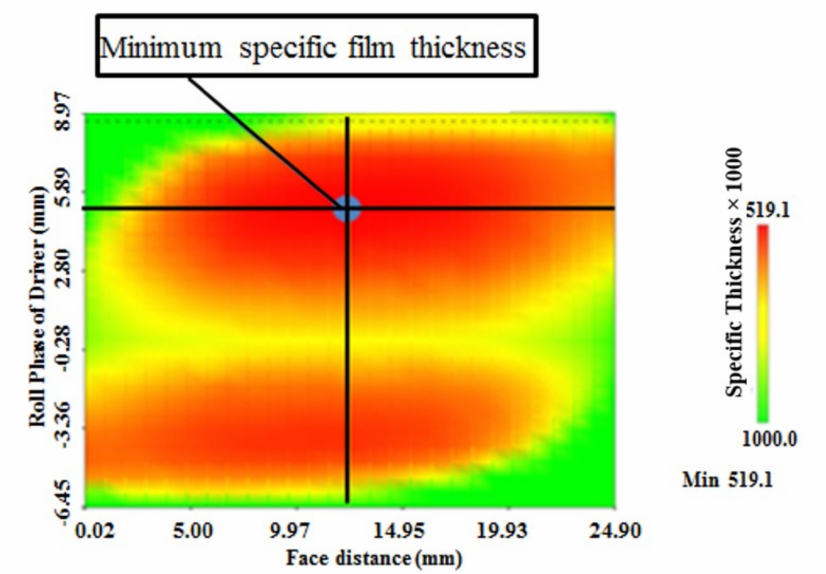
Figure 11. Specific film thickness of pinion for distance of pulling up equal to 3.1 mm.